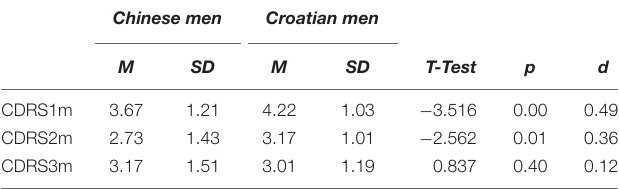
CDRS1m- figure men perceived as the most attractive; CDRS2m – figure men thought most women find the most attractive and wish to have; CDRS3m- figure men thought was most widely represented in the